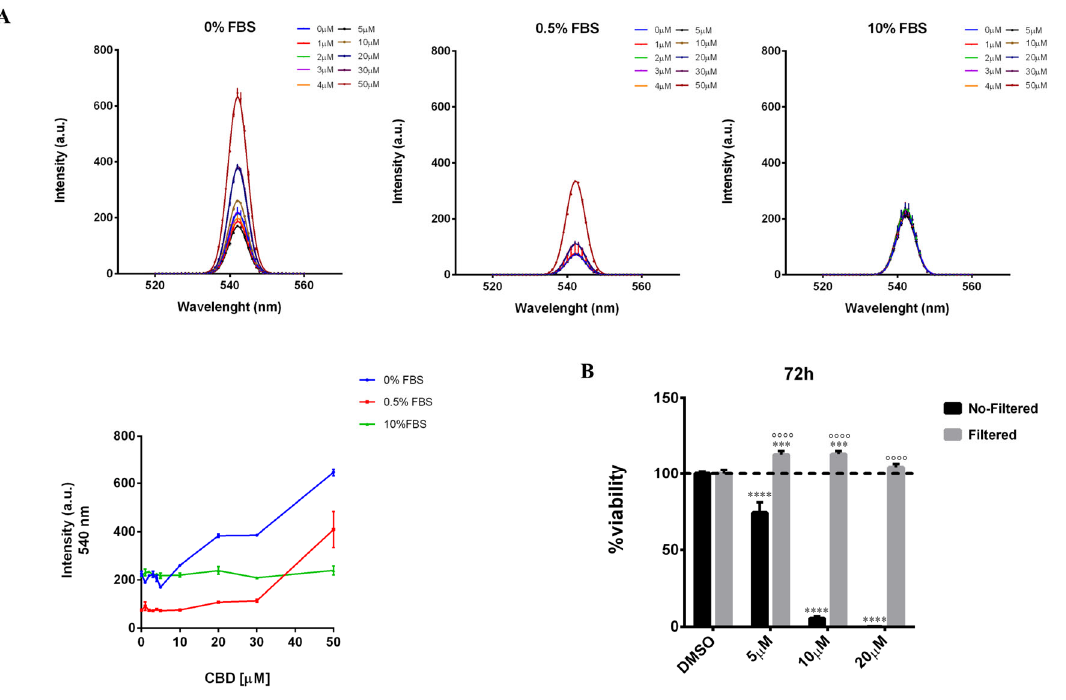
Figure 5. Serum exerts a surfactant action on CBD-aggregates. ( A ) Light scattering spectra of increasing concentrations of CBD in DMEM medium (without phenol red) supplemented with different concentrations of serum (0% FBS, 0.5% FBS, 10% FBS). On the bottom left, a graphical representation of the light scattering of the samples at 540 nm. ( B ) MDA-MB-231 cells were plated on 96-well plates. The day after, cells were treated as described in Materials and Methods. Cell viability was quantified after 72 h of the treatment. No-Filtered = CBD was added in DMEM medium without phenol red (containing 0.5% FBS) and then cells were treated with this solution. Filtered = CBD was added in DMEM medium without phenol red (containing 0.5% FBS); after that, the solution was incubated at 37 °C for 20 min, then it was filtered and added to cells. Data are expressed as mean ± S.E.M. from three independent experiments. Differences among groups were analyzed using two ‐ way ANOVA followed by Sidak’s test for group comparison and multiple t ‐ tests.*** p < 0.001, **** p < 0.0001 indicated significance compared to DMSO. ∘∘∘∘ p < 0.0001 indicated significance compared to the No ‐ Filtered sample at the same concentration.